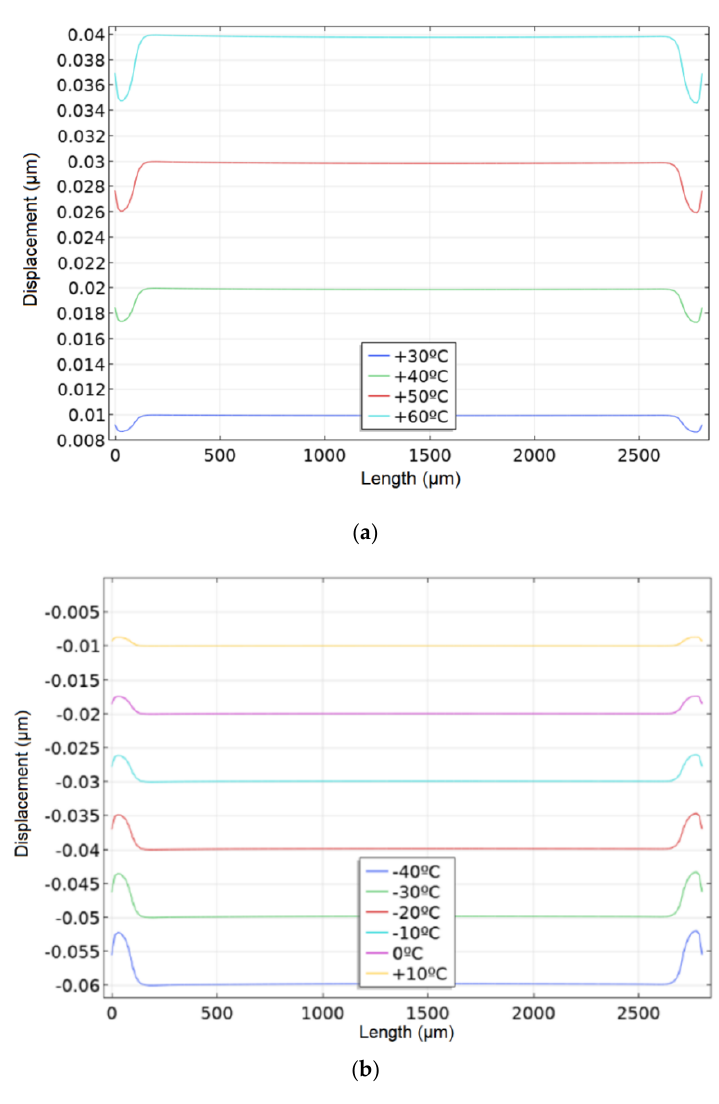
Figure 12. Load distribution ( a ) and displacement ( b ) graphs for quartz. Table 3. Deformation of the console when heating or cooling ( µ